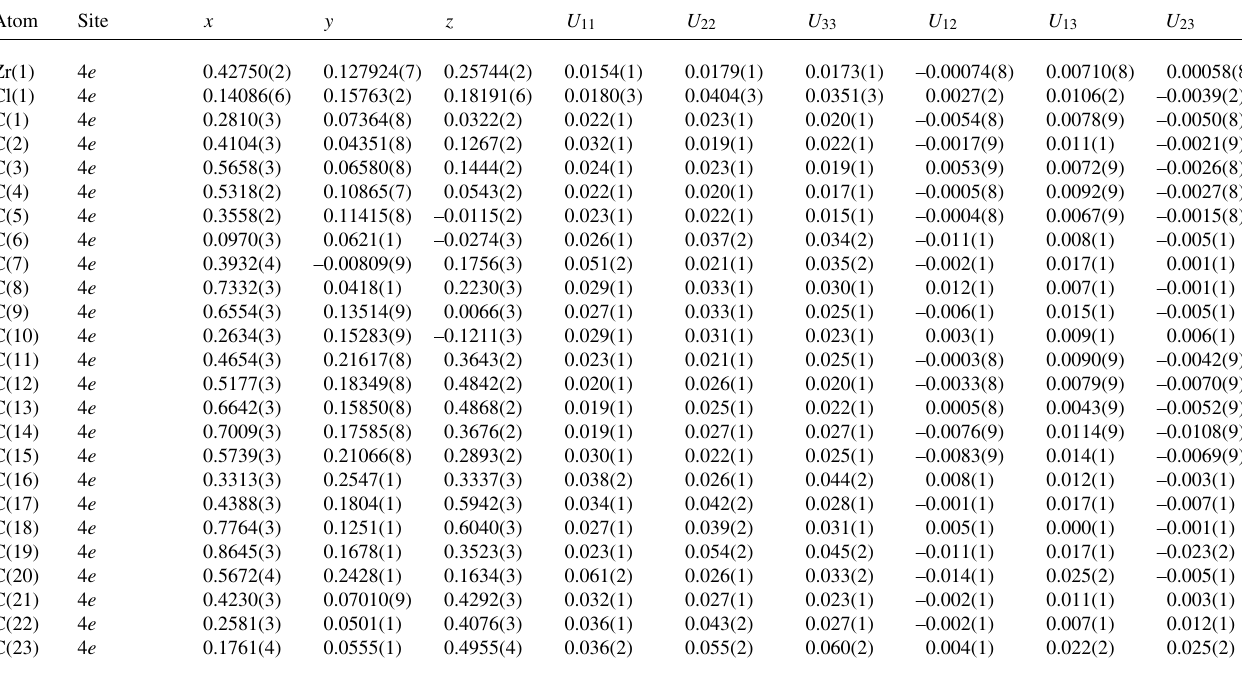
Table 3. Atomic coordinates and displacement parameters (in Å 2 )